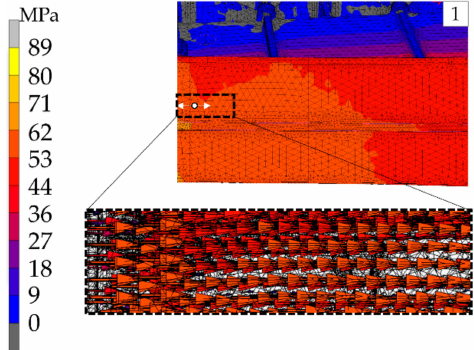
Figure 5. Strain gauge locations (numbers from 1 to 6) and tensile specimen positions (A, B, M).